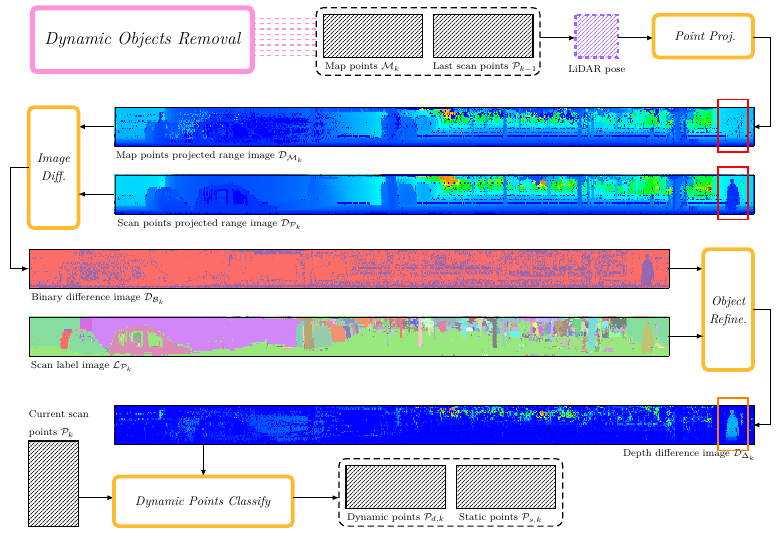
Figure 5. The workflow of